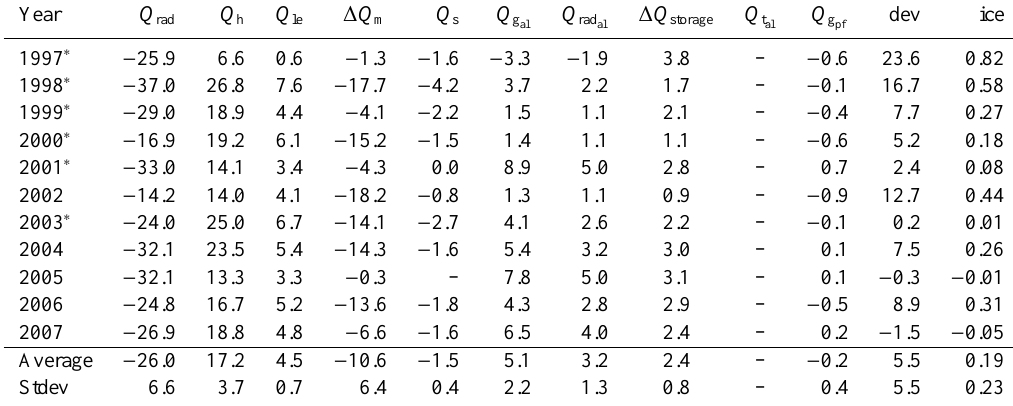
Table 3. Seasonal (October–January) averages of the energy balance components with deviations (in Wm − 2 ) and corresponding ice thickness equivalents (in m). Years marked with an asterik were not considered for the calculation of the average and the standard deviation. Q rad : Net radiation; Q h : Sensible heat flux at the surface; Q le : Latent heat flux at the surface; ∆ Q m : Melt energy in the snow cover; Q s : Conductive heat flux through the snow; Q g : Conductive heat flux within the active layer; Q rad : Net radiation in the active layer; ∆ Q storage : Change in heat al al content in the active layer; Q t : Turbulent heat flux in the active layer; Q g : Conductive heat flux through the permafrost table; dev: Energy al pf balance closure; ice: Ice melt equivalent of the energy balance